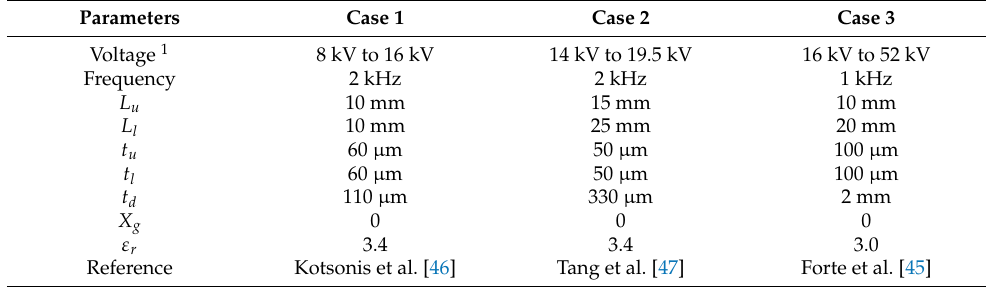
Table 5. Parameters for the simulation